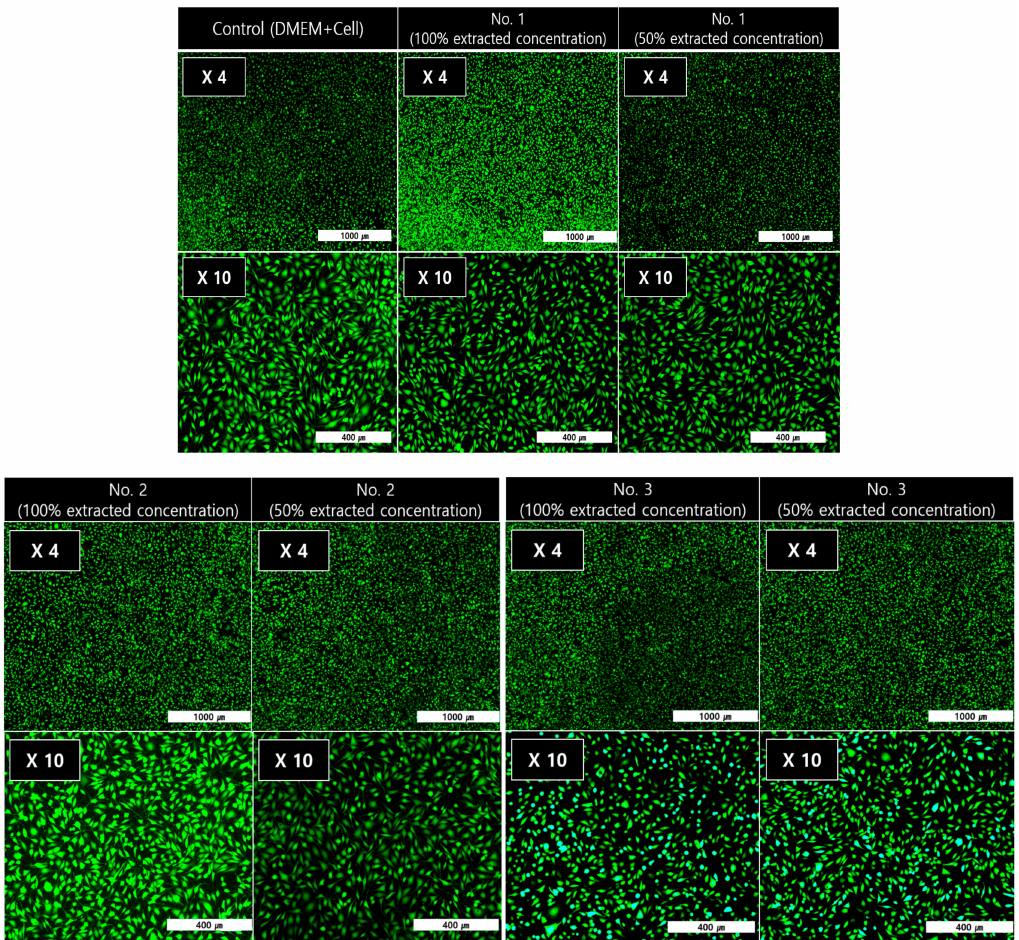
Figure 10. Images of cell viability via Live / Dead